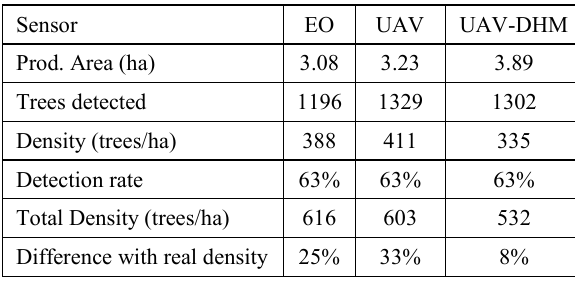
Table 2. Number of stem